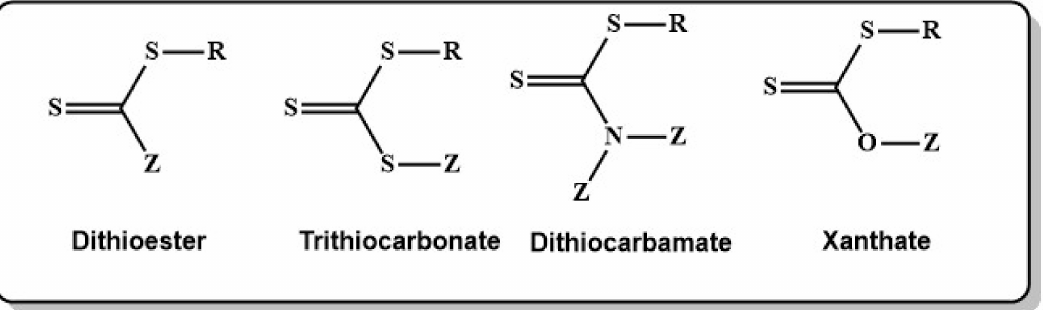
Chart 7. Typical chain transfer agents used in